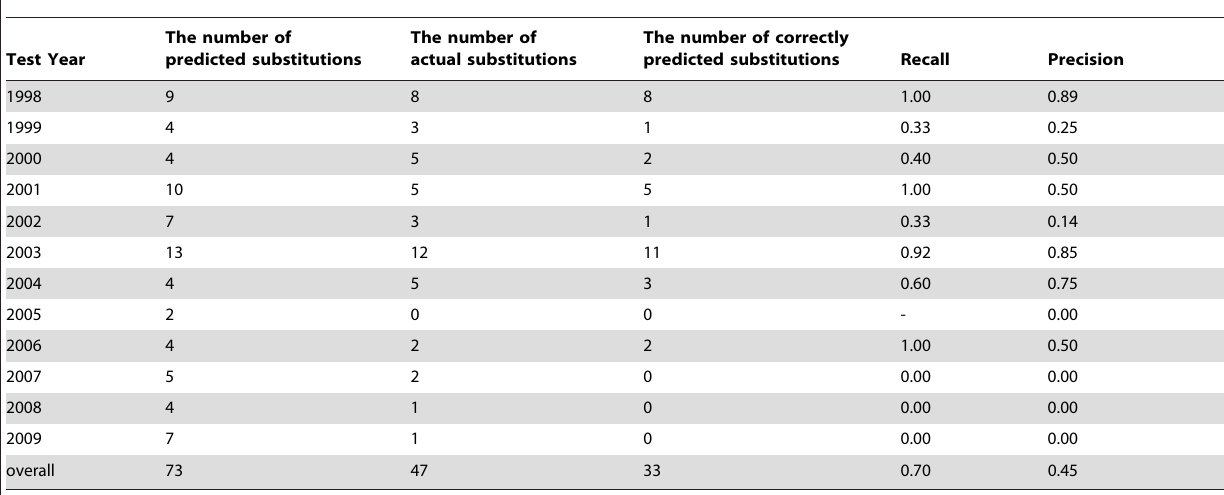
Table 1. Results of retrospective tests for the prediction of amino acid substitutions.